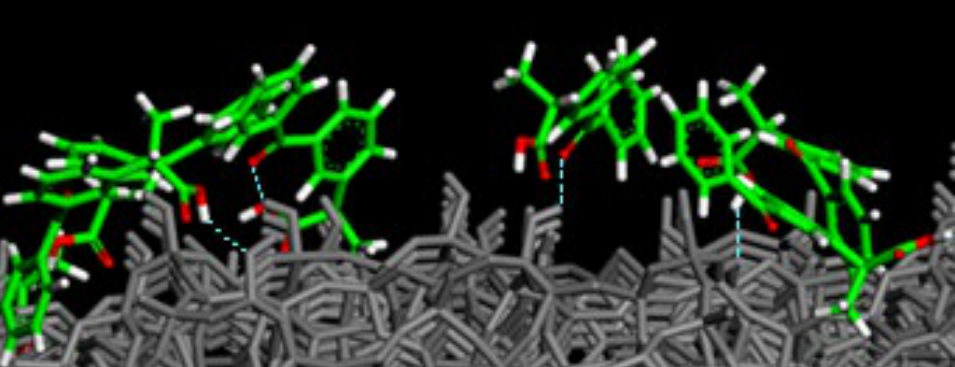
Figure 4. Particular of the optimized geometry of 14 ketoprofen drug molecules in racemic mixture adsorbed on dried amorphous SiO 2 surface, then without water molecules, after 2 ns in vacuo and energy minimization. In particular the Figure shows the side view of ketoprofen molecules interacting with SiO 2 surface forming H-bonds. Color code: all surface atoms are in grey, ketoprofen carbon atoms are in green, oxygens in red and hydrogen atoms in white. H-bond with the SiO 2 surface is reported in dashed blue lines.